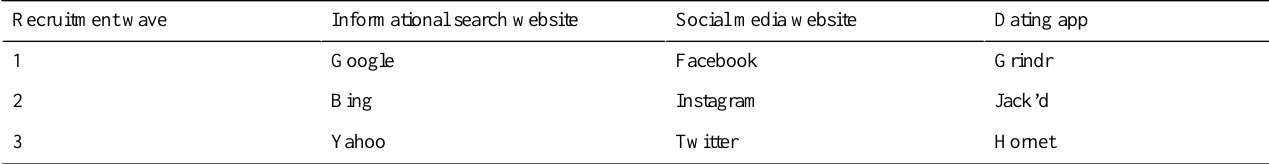
Table 1. HIV self-test study recruitment waves and web-based